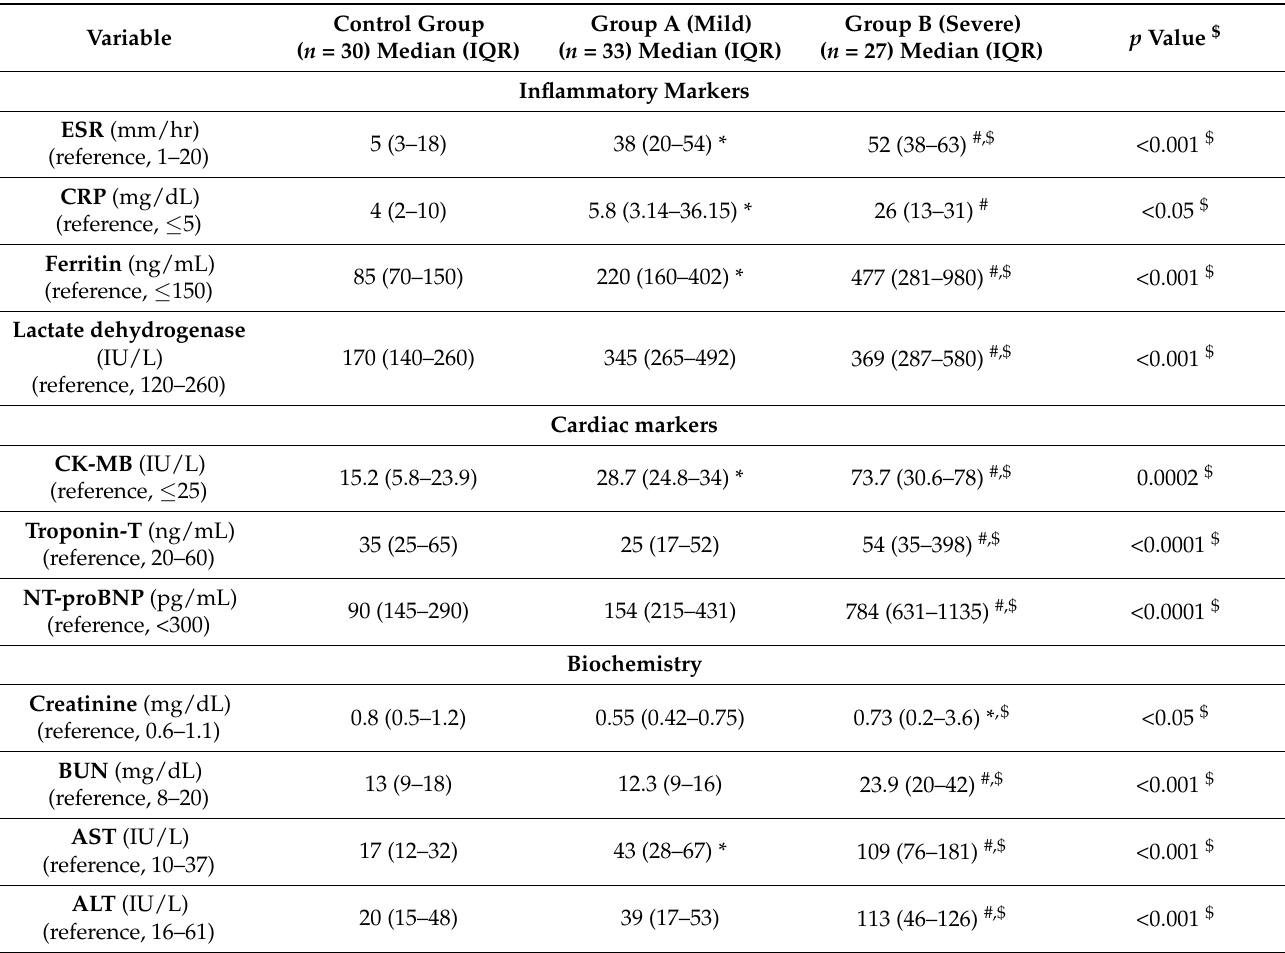
Table 2. Inflammatory markers, cardiac injury markers, and biochemical workup of the study cohort on Day 1 after admission with MIS-C manifestations.